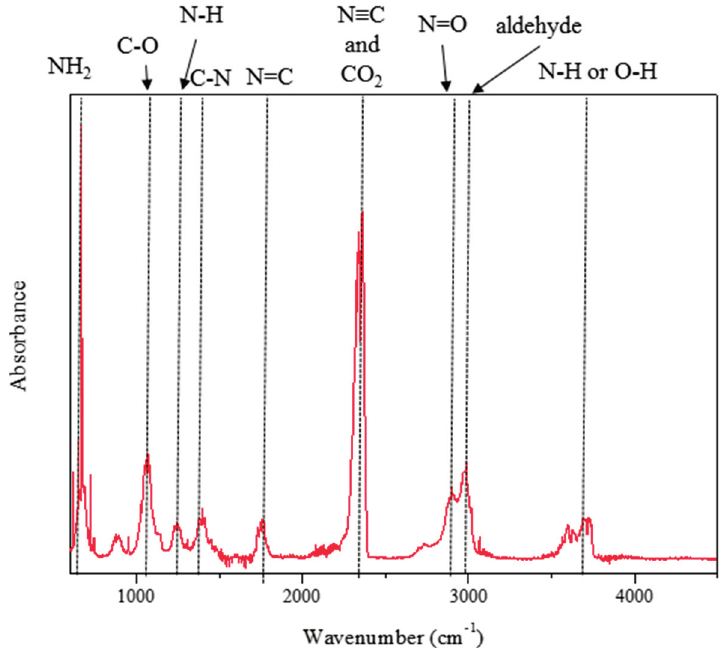
Figure 11. FT-IR spectrum of explosion gas of an mixture hypergolic chemicals with [EMT] + [CN] − and HOCH 2 CH 2 NHNH 2 using H 2 O 2